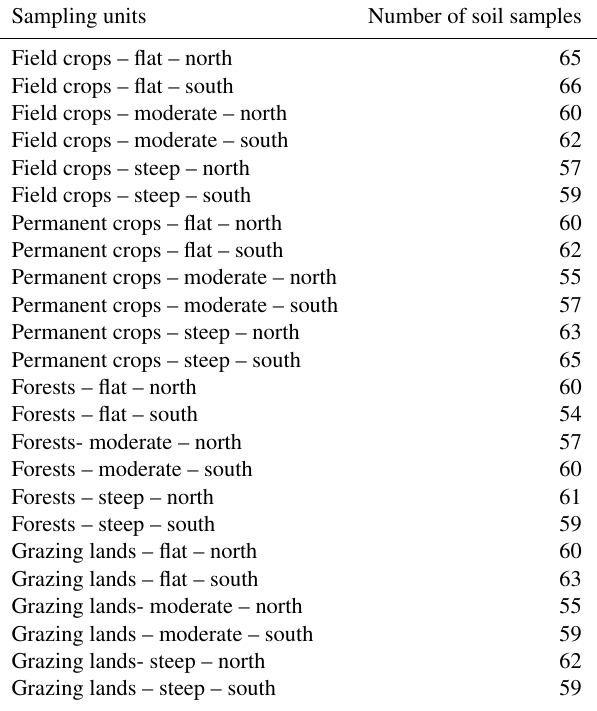
Table 3. Sampling units with their corresponding number of soil